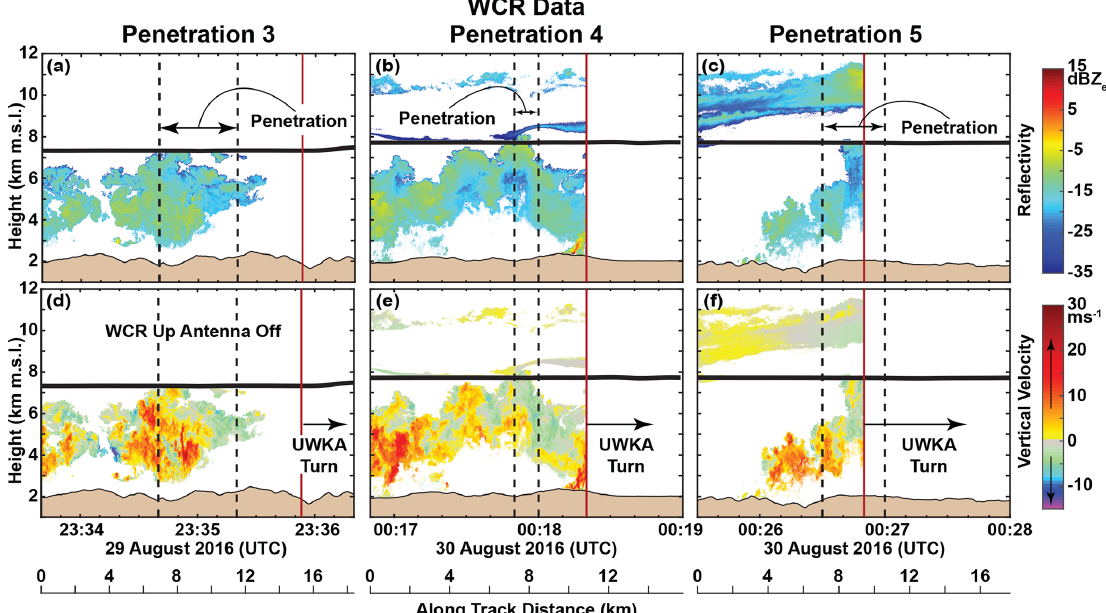
Figure 13. UWKA WCR (a–c) reflectivity and (d–f) radial velocity (effectively vertical velocity) data for (a, d) penetration 3, (b, e) pene- tration 4, and (c, f) penetration 5 (Fig. 1d, Table 2) and 60s before and after each of the penetrations (bounded by the vertical, dashed black lines). Color scales to the right of each row indicate plotted values. Aircraft track shown by the bold black lines near the middle of each panel. Underlying topography indicated by the filled tan outline at the bottom of each panel. Along-track distance for the penetrations shown at bottom. Periods without WCR data bounded by vertical red